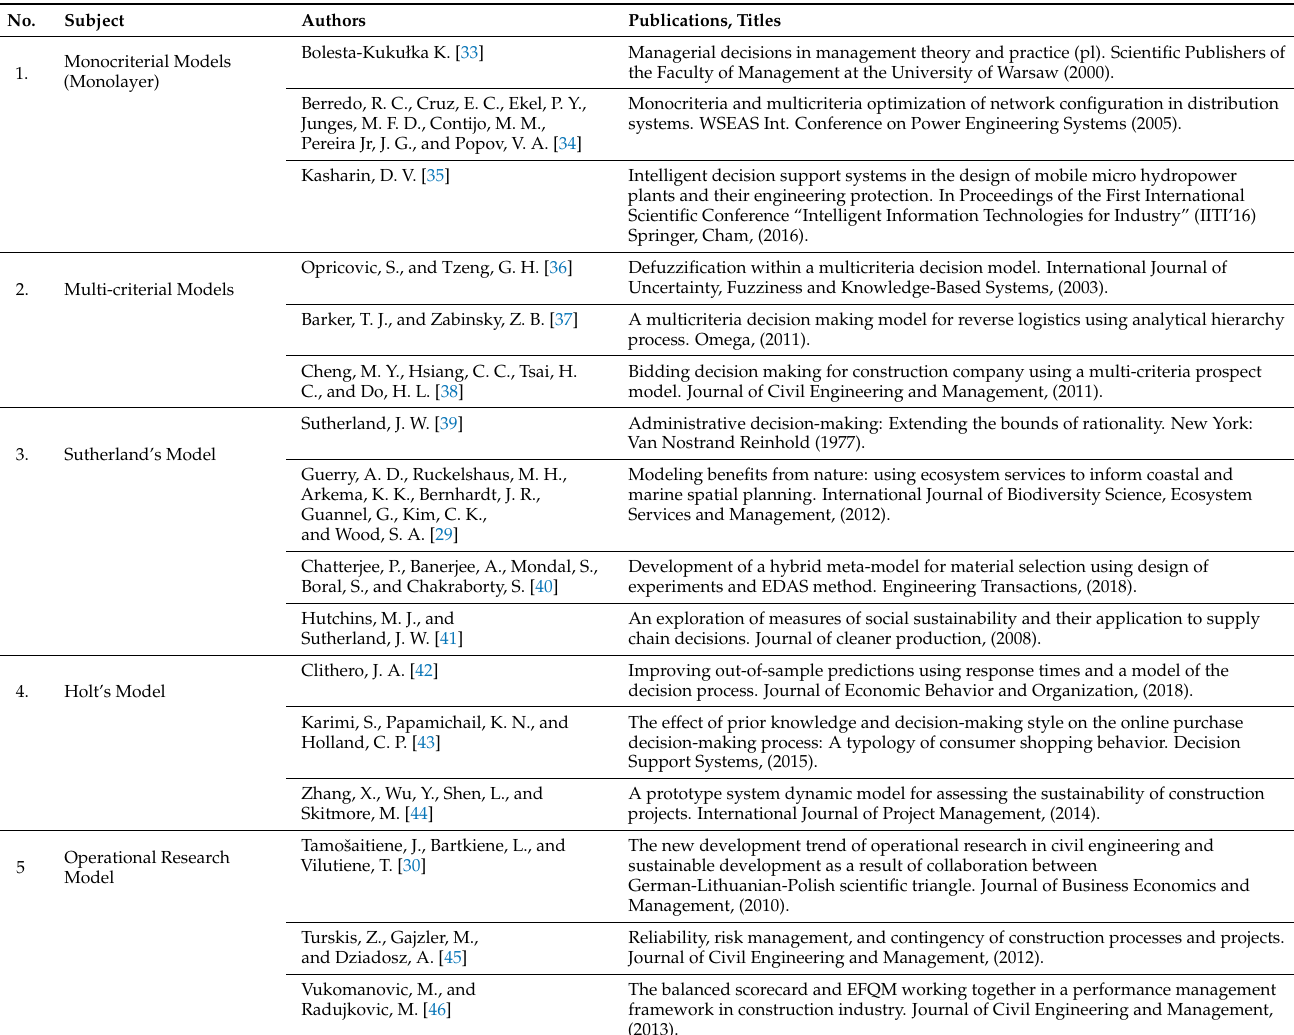
Table 1. Models of a decision-making process—literature